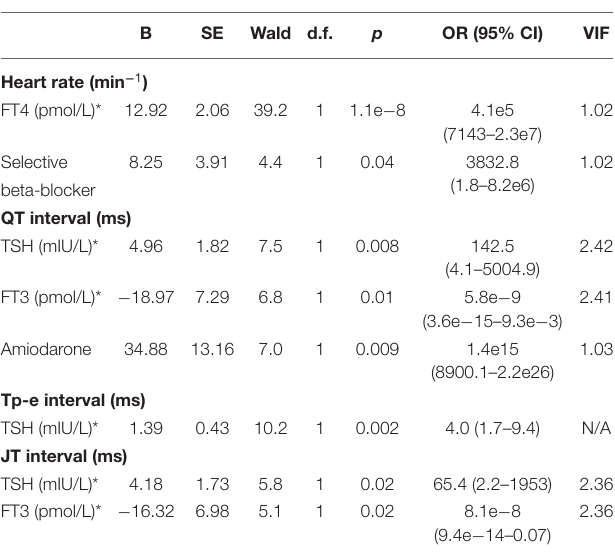
TABLE 3 | Heart rhythm characteristics in the four groups. TABLE 4 | Minimal models of multivariable